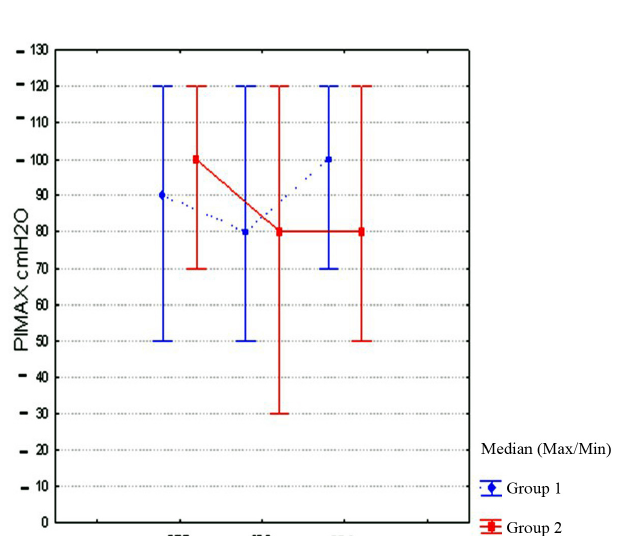
Fig. 2 - Median maximum inspiratory pressure ( MIP) variable in different moments of the operation of each group analyzed (with and without physical therapy preoperatively). Friedman test for comparison of moments in each group and Mann Whitney test to compare the groups at each time, *P<0.05.